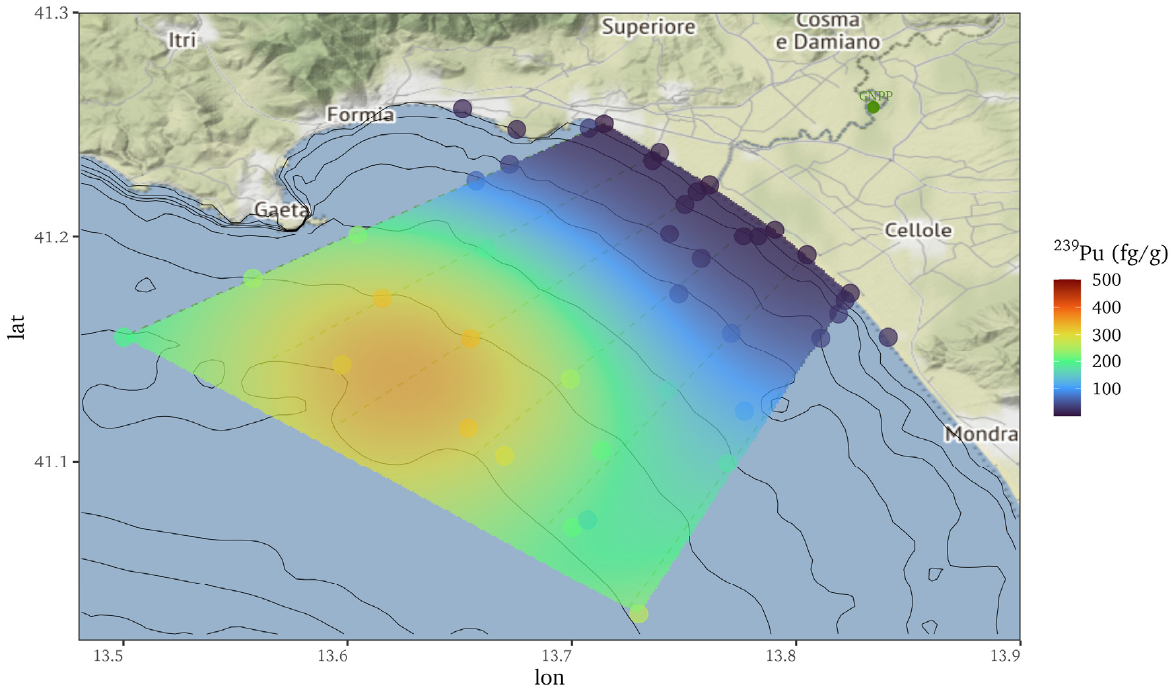
Figure 13. Map of the 239 Pu concentrations in marine sediments.